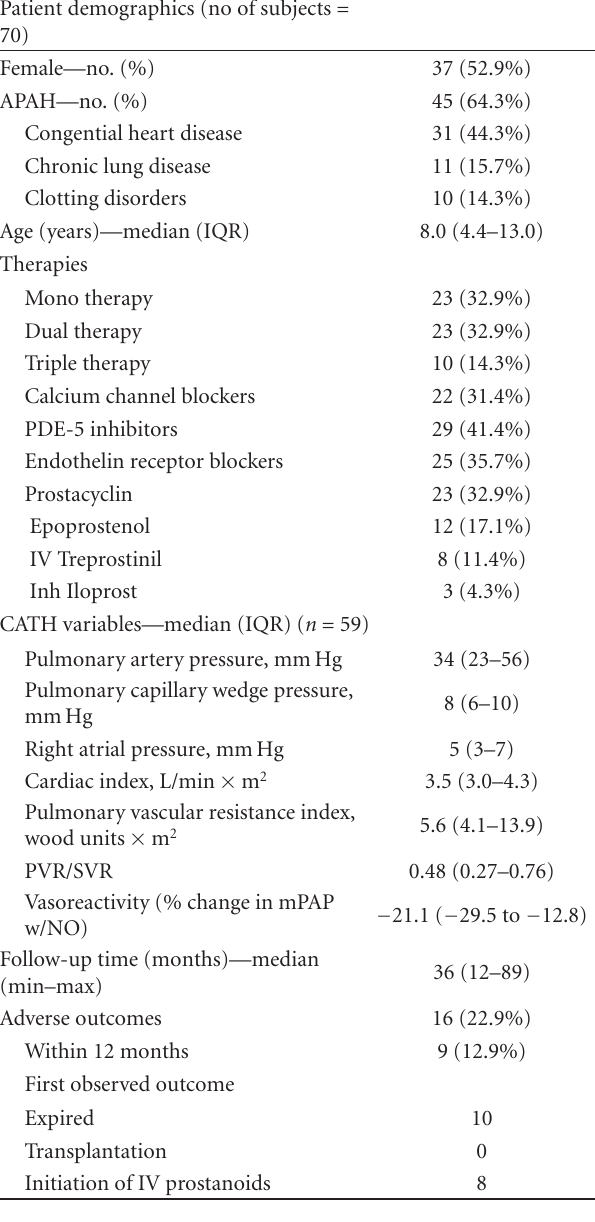
Table 1: Patient demographics and clinical